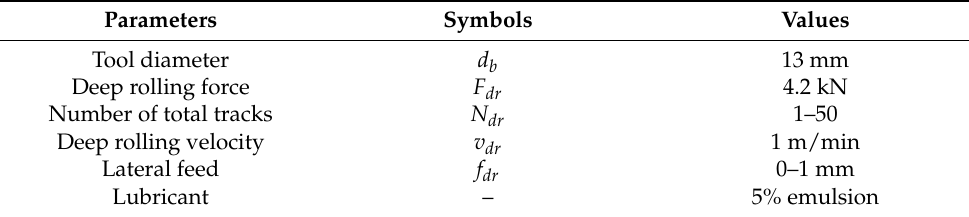
Table 4. Deep rolling